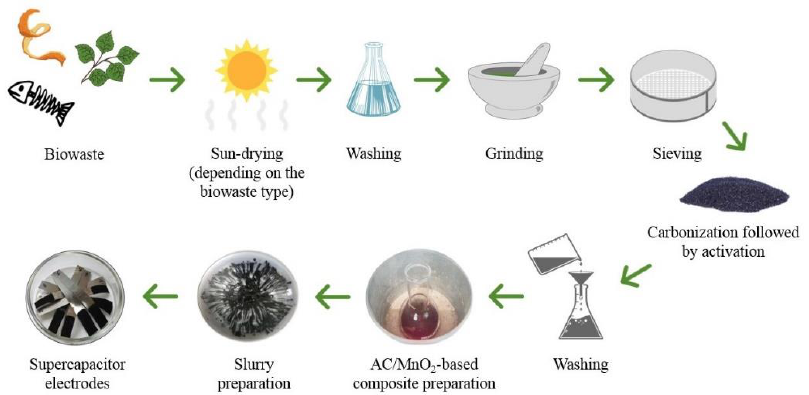
Figure 4. Scheme of preparation of biowaste-derived AC/MnO 2 -based composite for supercapacitor electrodes. This figure was created by using the Canva application.